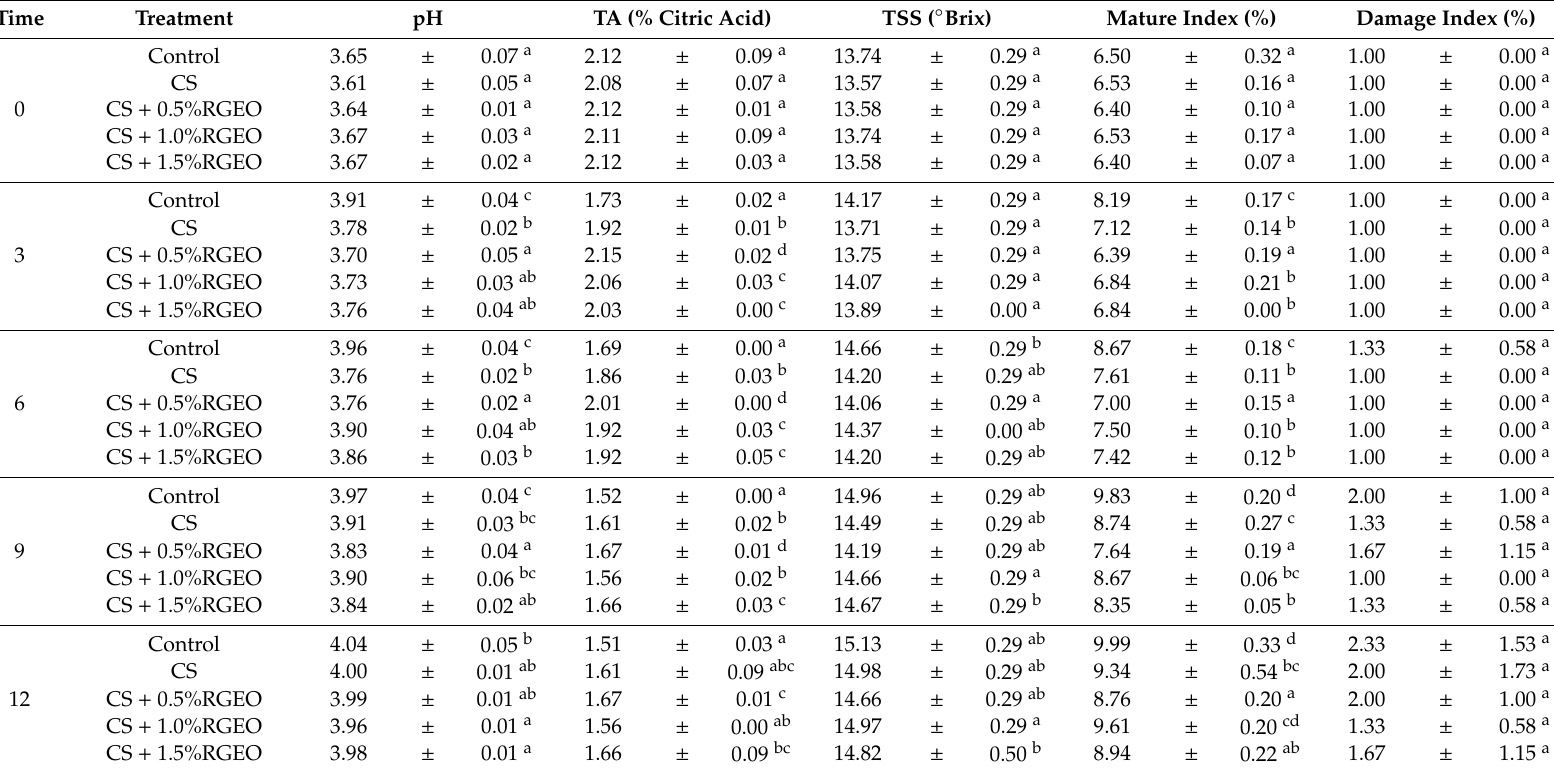
Table 2. Physical-chemical characteristic in P. peruviana with CS + RGEO coatings stored for 12 days at 18 ± 2 ◦ C. T1 = Control; T2 = CS; T3 = CS + RGEO